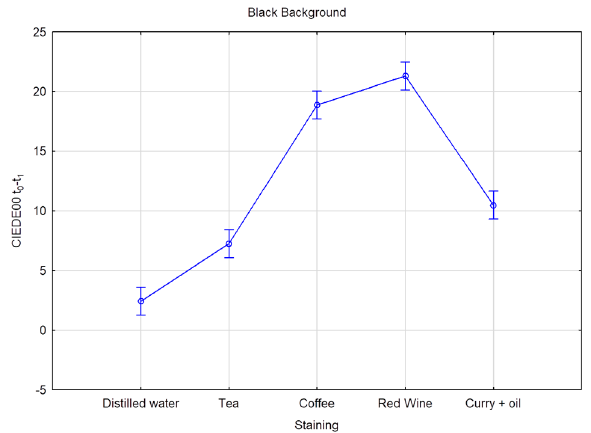
Figure 4. Average color difference in terms of CIEDE00 (t0-t1) according to different staining liquids analyzed over a black background. Vertical bars denote 95% confidence intervals.